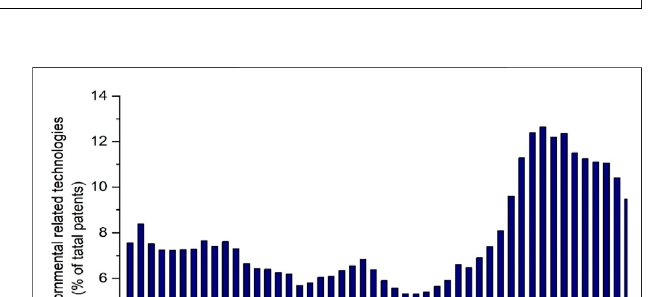
FIGURE 2 | Box chart of variables with scatterplot and distribution.